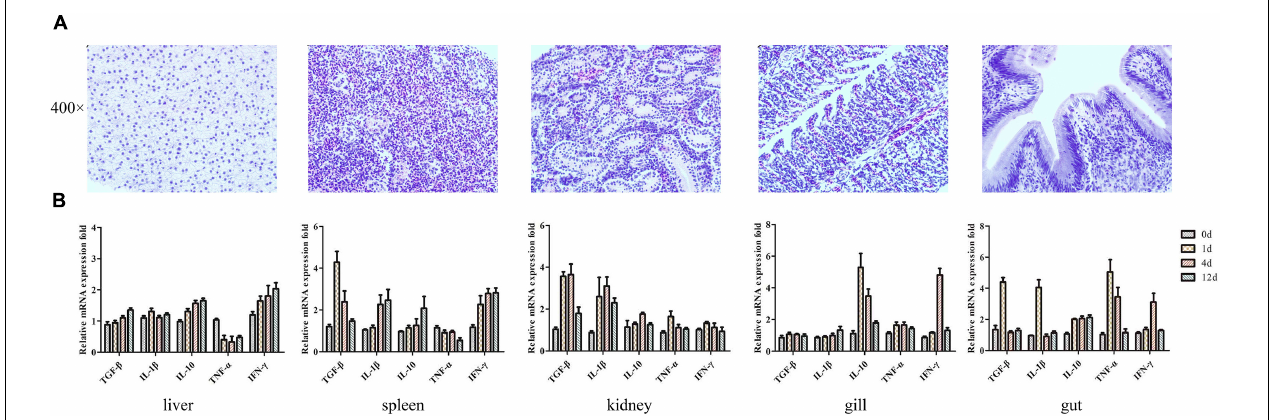
FIGURE 6 | Transcriptional analysis of histopathology and immune-related genes (TGF- β , IL-1 β , IL-10, TNF- α , and IFN- γ ) in crucian carps upon exposure to PZL-Ah152 for 12 days. Experiments were conducted as independent duplicate experiments for control and phage exposure. Tissues were pooled ( n = 3) at each time point for each replicate group. (A) The safety of using PZL-Ah152 as a potential therapeutic was examined by exposing crucian carps to PZL-Ah152 for 12 consecutive days. The tissues of crucian carp were extracted at 12 days and stained with hematoxylin and eosin. (B) Relative mRNA expression fold change for a particular candidate gene of PZL-Ah152 exposed fish at day 1 =